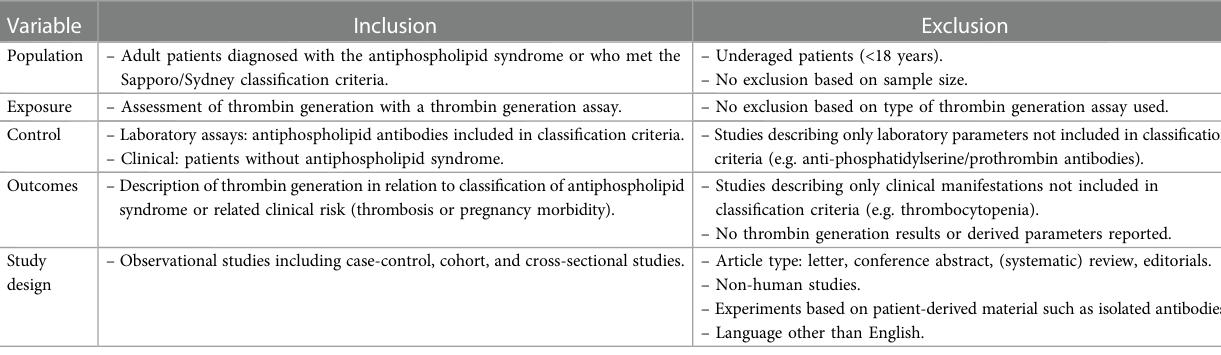
TABLE 1 Eligibility criteria for assessing inclusion and exclusion of retrieved